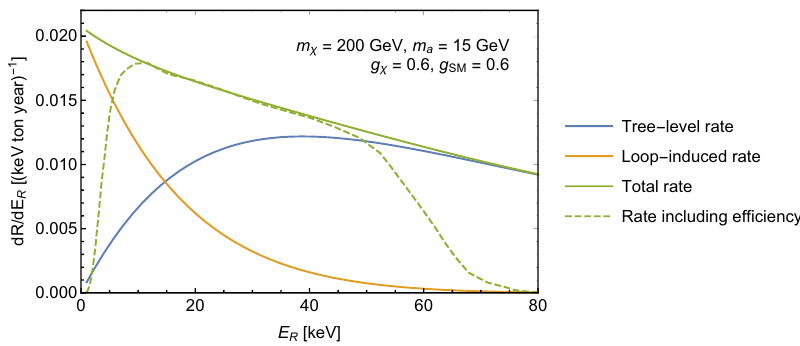
Figure 7 . Predicted di(cid:11)erential event rate in LZ for a speci(cid:12)c parameter point in the model with maximal CP violation ( (cid:30) (cid:31) = 0, (cid:30) SM = (cid:25)= 2) consistent with all current